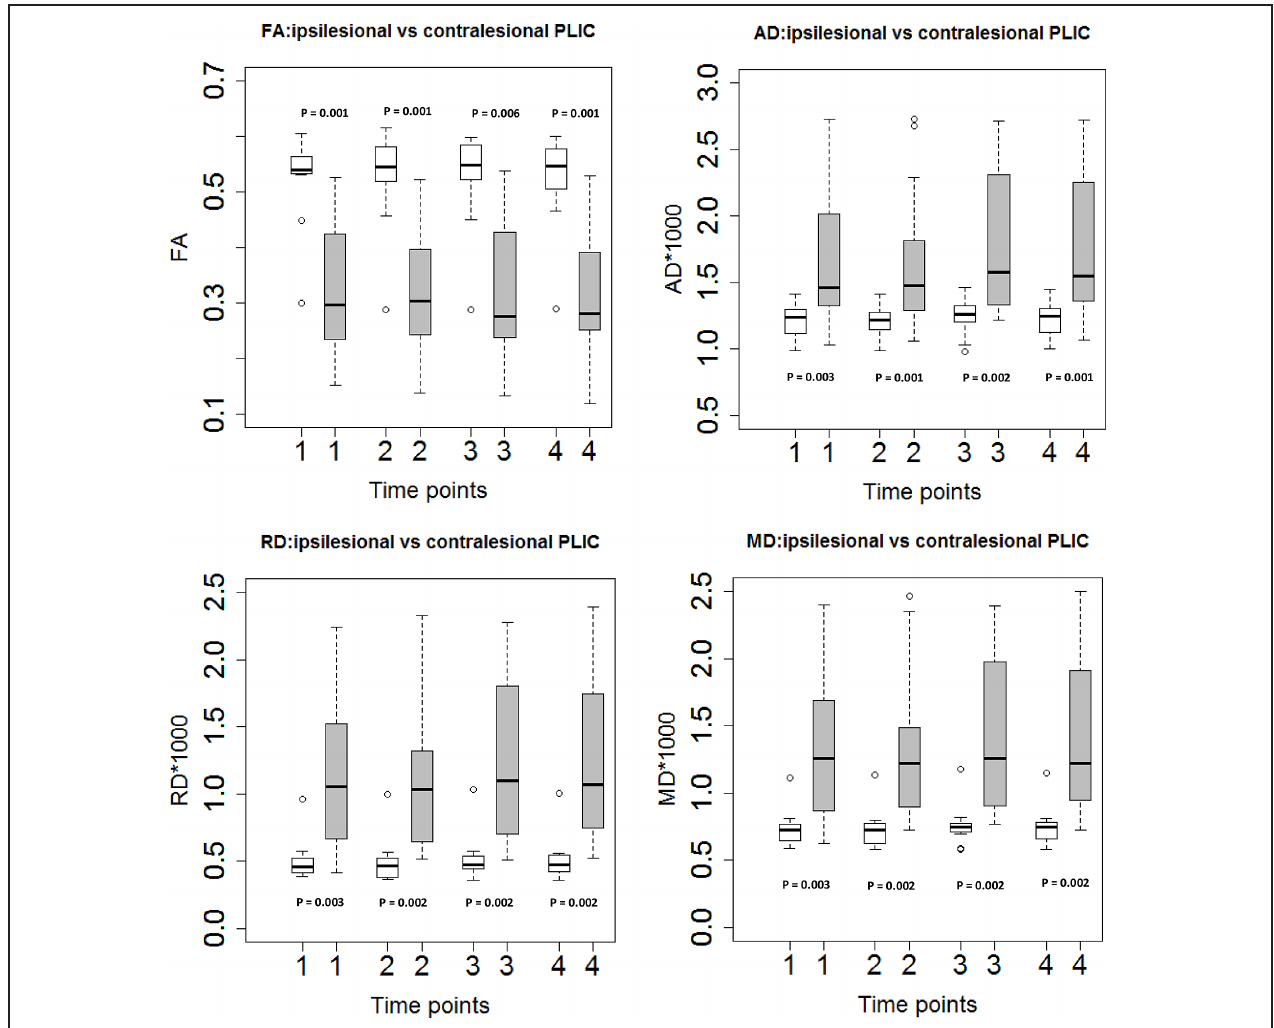
FIGURE 2 | Diffusion tensor imaging measures in ipsilesional and contralesional PLIC. Boxplots showed significantly higher FA, lower diffusivity measures (AD, RD, and MD) in the ipsilesional PLIC (Wilcoxon signed-rank tests).Time of immediately pre-, mid-,